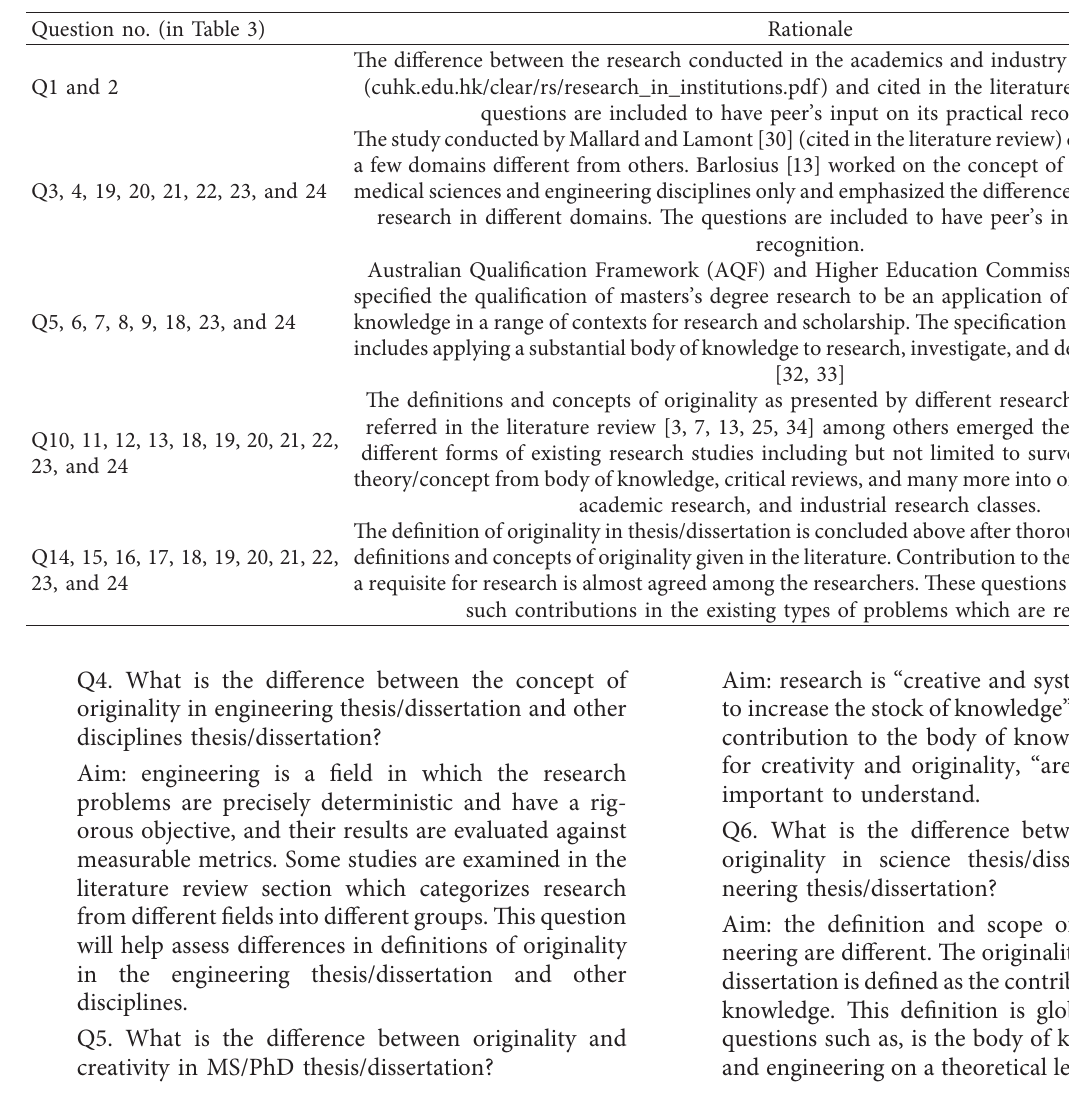
Table 3: : Rationale of the questions added in the questionnaire given in Table 3 (Annex